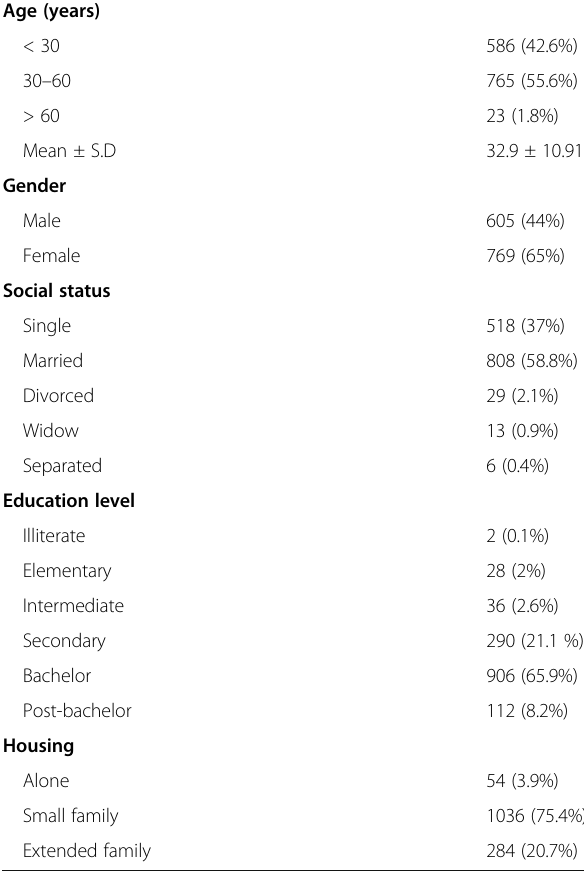
Table 1 Demographic